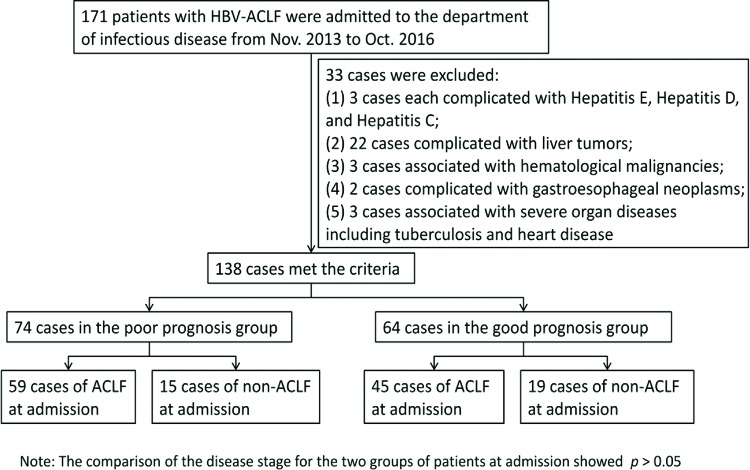
Case screening and enrollment. No statistically significant difference was observed between the poor prognosis group and the good prognosis group in terms of disease stage at admission.